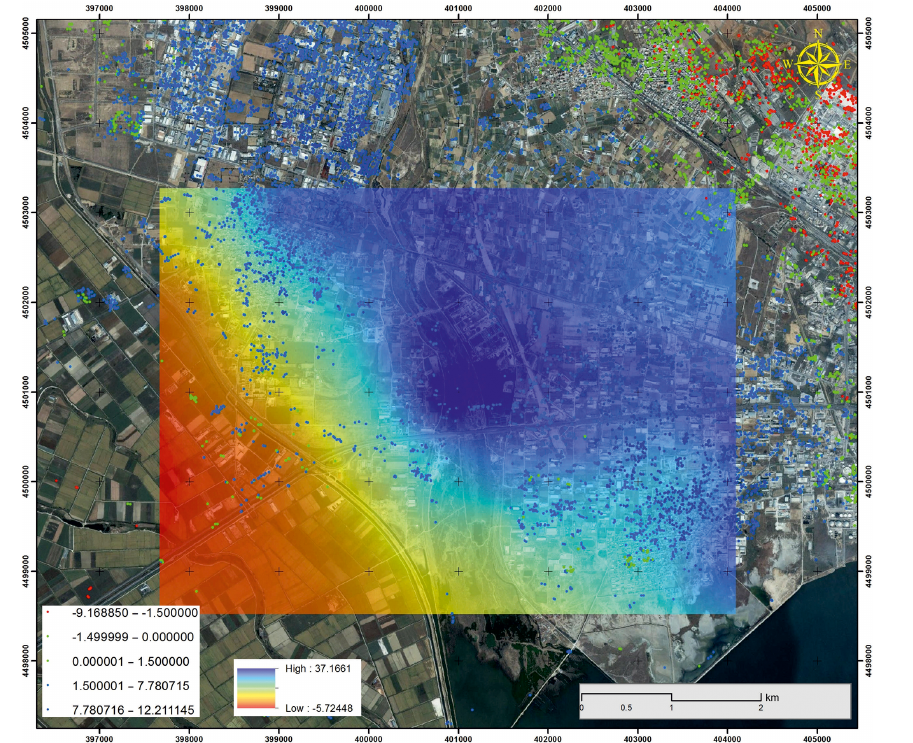
Figure 3. The groundwater recharge (contour shading in m) between June 2000 and June 2015 correlated with the displacements along LOS in mmyr − 1 from 2003 to 2010 (SAR data – dots). The aquifers recharge triggers the uplift of the study area (Svigkas et al., 2016).